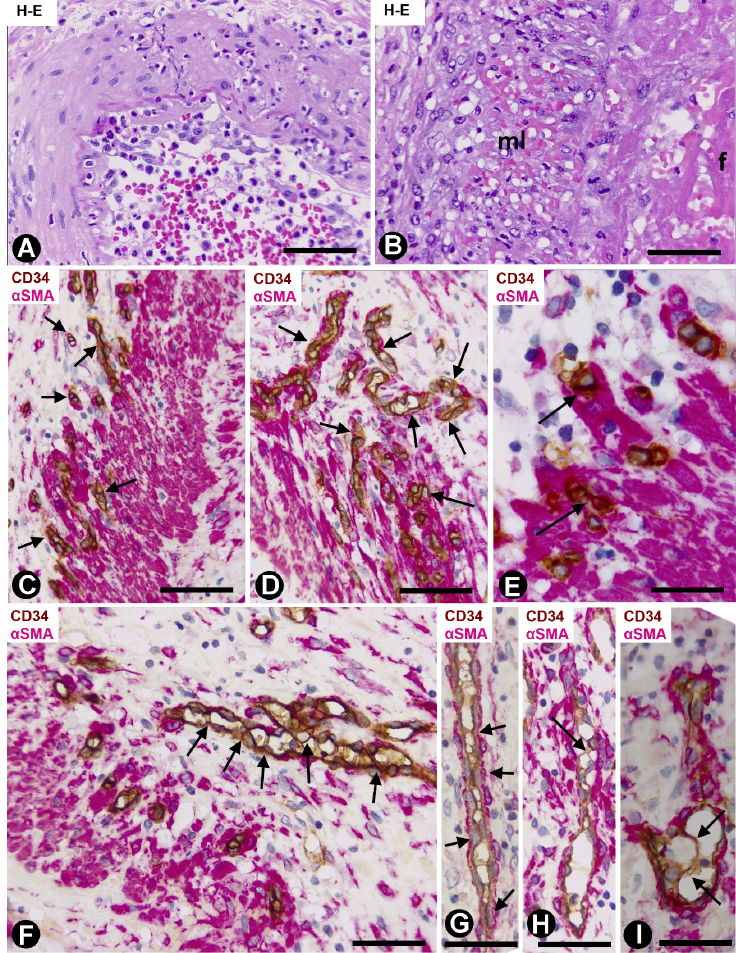
Figure 1. Arteries in gallbladders with acute cholecystitis and urgent cholecystectomy. Sections stained with Hematoxylin-Eosin (HE) ( A , B ) and double-immunostained with anti-CD34 (brown) and anti- α smooth muscle actin α SMA (red) ( C – I ). ( A ) Arterial segment in which parietal and luminal infiltration of lymphocytes and neutrophils is observed. Note the loss of the intimal endothelium. ( B ) Presence of fibrin (f) in the arterial lumen and red blood cells in the media layer (ml). ( C , D ) Numerous microvessels (arrows) with endothelial cells (ECs) (brown) and pericytes (red) are seen in the adventitia. ( E ) Microvessels in the arterial media layer. Observe that the ECs (brown) seem to be surrounded by smooth muscle cells (arrows). ( F – I ) Presence of EC bridges and endothelial contacts in the adventitial microvessels (arrows). Bar: ( A , B ): 100 μ m; ( C , D , F – I ): 80 μ m; ( E ): 30 μ m.